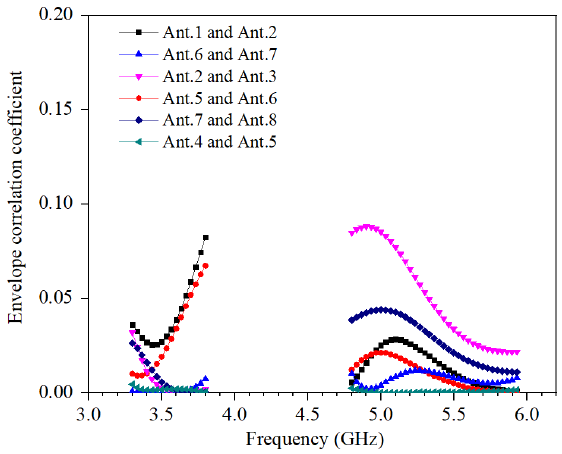
The calculated ECC of the proposed MIMO antenna system is shown in Figure 8. The values of ECC in the operating frequency bands are smaller than 0.09. The values of ECC in the operating frequency bands are smaller than 0.09.